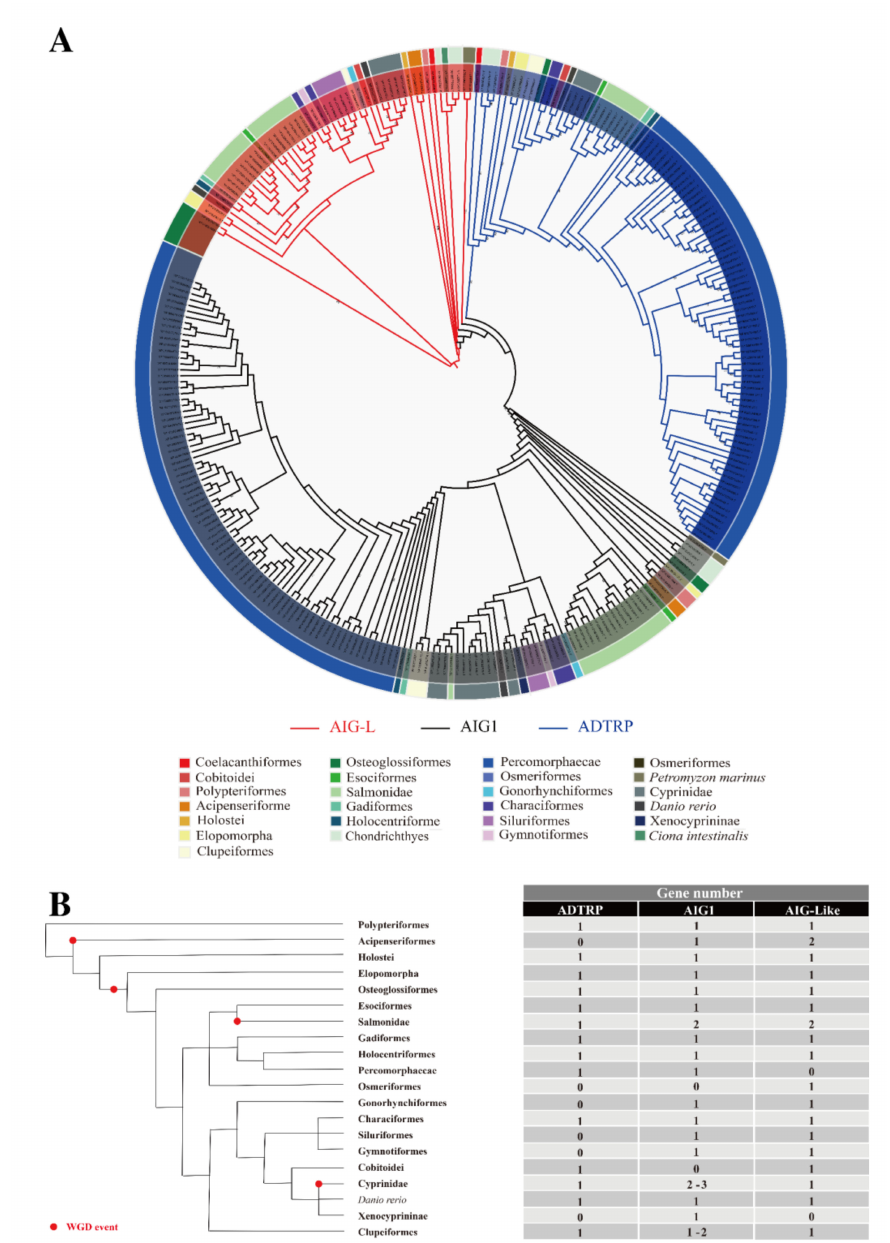
Figure 4. The classification of fish AIG proteins. ( A ) Phylogenetic analysis of AIG proteins in Urochordate, Chondrichthyes, and Osteichthyes using the ML approach with RAxML-NG. The branches with bootstrap values > 60 are labeled in the figure. AIG1-L, AIG1, and ADTRP branches are highlighted in red, black, and blue, respectively. Additionally, AIG-L from Ciona intestinalis was grouped with other AIG-Ls. ( B ) Gene numbers of each AIG member of each fish taxonomic unit were estimated and presented as a fish cladogram. The WGD events are denoted in the cladogram by red